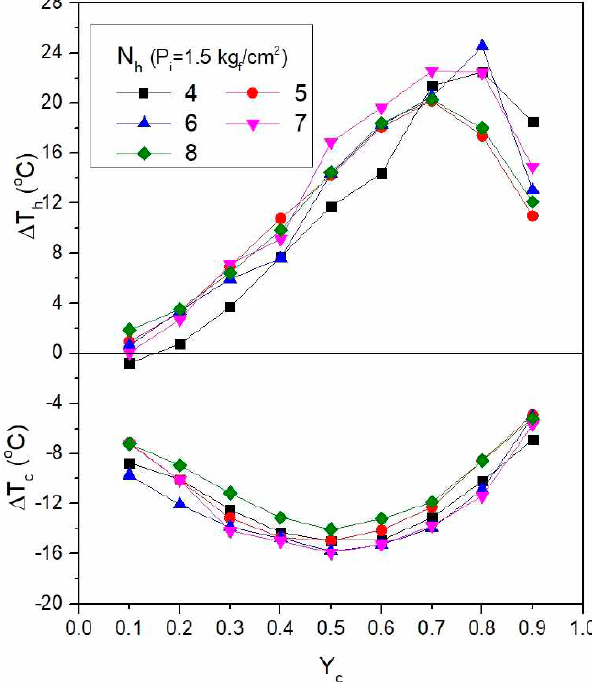
∆ T c according to inlet pressure (P i ) 1.5 kgf h and